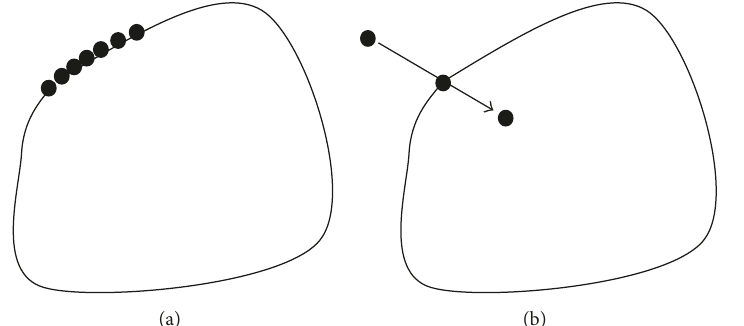
Figure 5: Comparison of different movement conditions of oil particles (black point) when arriving at the solid boundary (solid line) ((a) represents the modes of the penetration-resistant boundary as well as the longshore transport and adsorption of the oil slick and (b) represents the unlikely case of oil particles penetrating the solid boundary).